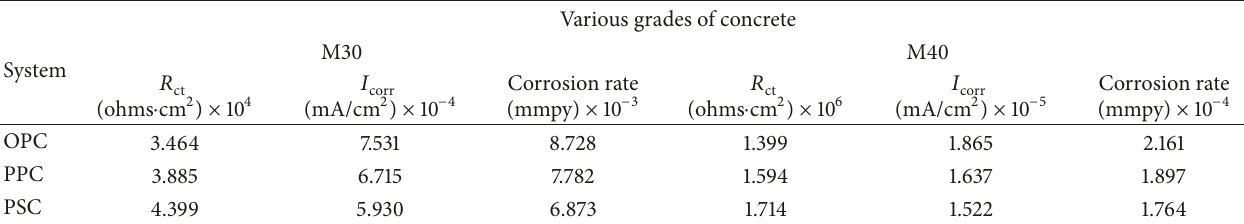
Table 7: AC-impedance parameters for the corrosion of rebar embedded in OPC, PPC, and PSC M40 grade concrete (90-day cured